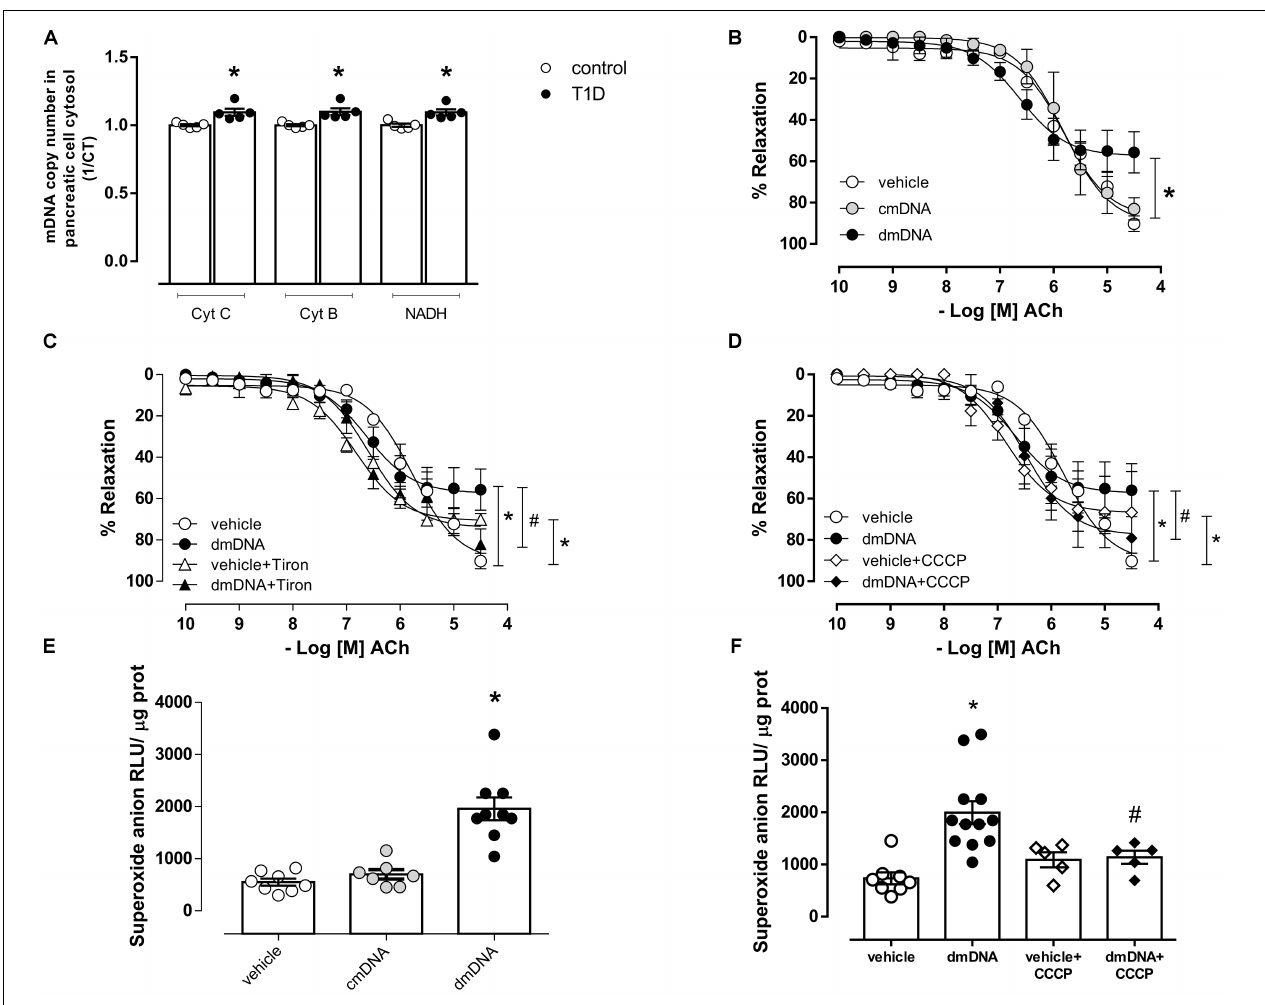
FIGURE 4 | (A) Quantification of mitochondrial DNA genes cytochrome C (Cyt C), cytochrome B (Cyt B) and NADH dehydrogenase (NADH) in the cytosolic fraction of pancreatic cells from non-diabetic (control, white circles) or diabetic (T1D, black circles) C57BL/6 mice. Gene expression was determined by RT-PCR. Each bar represents the mean ± SEM. ∗ P < 0.05 vs. control, N = 3–5. Cumulative concentration-response curves to Acetylcholine (ACh), endothelium-dependent vasodilator, in resistance mesenteric arteries from C57BL/6 mice incubated with (B) vehicle (white circles), mitochondrial DNA from control (cmDNA, gray circles) or diabetic (dmDNA, black circles) mice. Acetylcholine responses in mesenteric arteries incubated with vehicle or dmDNA were also performed in the presence of (C) Tiron [vehicle+Tiron (white triangles) or dmDNA+Tiron (black triangles)] and (D) CCCP [vehicle+CCCP (white diamonds) or dmDNA+CCCP (black diamonds)]. Superoxide anion generation in endothelial cells incubated with (E) vehicle (white circles), cmDNA (gray circles) or dmDNA (black circles) and in the presence of (F) CCCP [vehicle+CCCP (white diamonds) or dmDNA+CCCP (black diamonds)]. Each point/column represents the mean ± SEM. ∗ P < 0.05 vs. vehicle, # P < 0.05 vs. dmDNA. N = 5–12, Student’s t -test (A) , one-way ANOVA (B–F) .